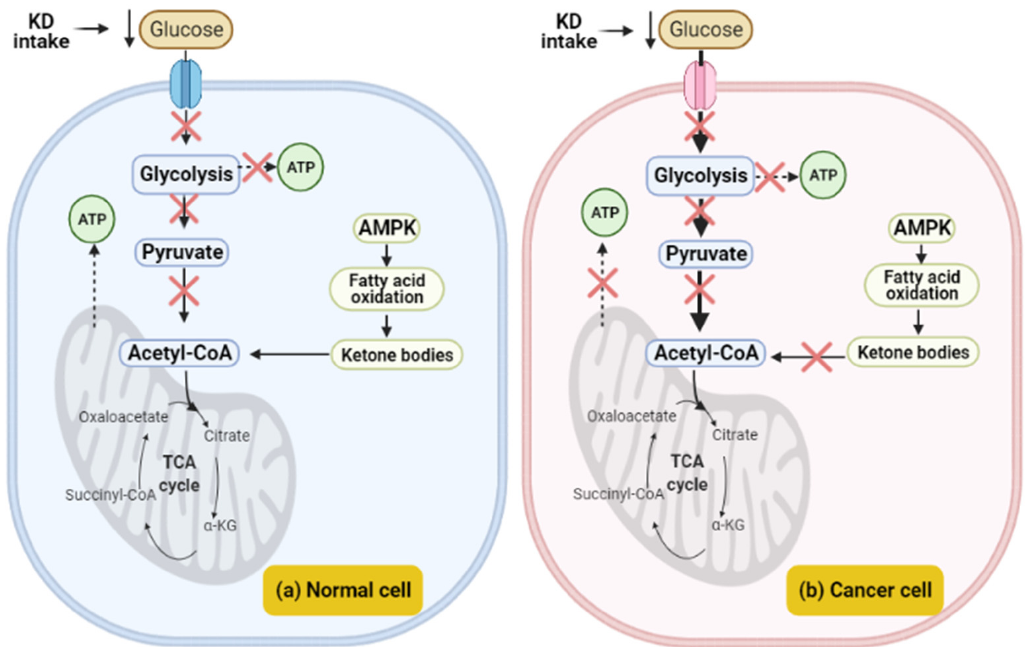
Figure 1. Scheme of cell behavior during ketogenic diet; ( a ) normal cell feeding with KD, lower level of glucose prevents glycolysis pathway, increases ketone body level as a result of fatty acid oxidation, thus enhancing level of acetyl-CoA in mitochondria to compensate for the ATP needing ( b ) cancer cell feeding with KD, and abolishes glycolysis. Additionally, the mitochondria are dysfunctional so the cell cannot produce ATP; thus, KD prevents cancer cell proliferation .